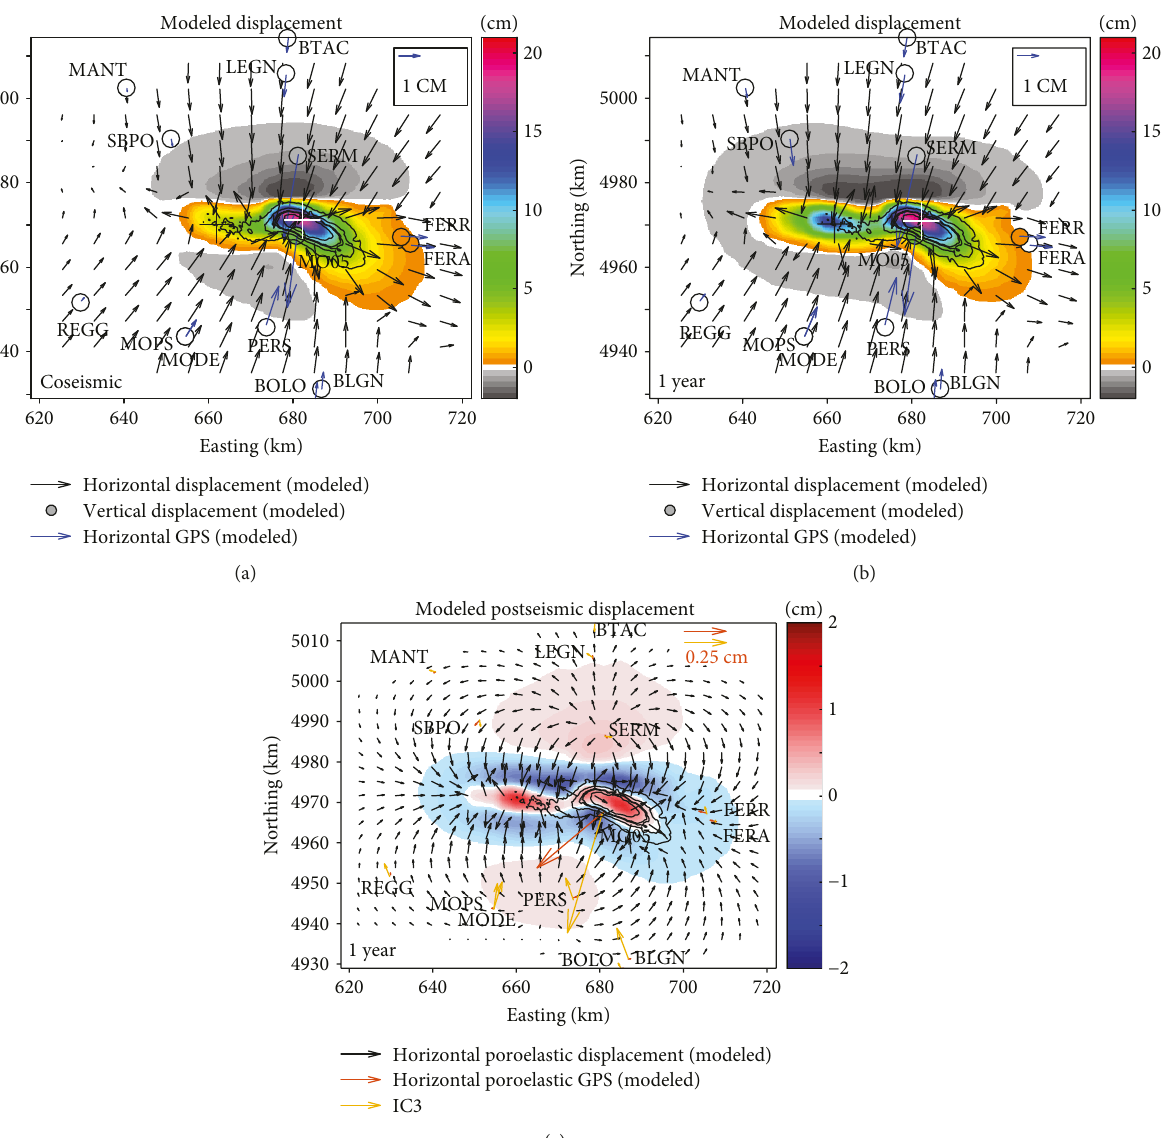
Figure 7: (a) Modeled coseismic vertical displacement and (b) after 1 year (color scale) under scenario S2. Black arrows: modeled horizontal displacement (logarithmic scale). Blue arrows: horizontal displacement modeled in the GPS locations (linear scale). The two white and black crosses are points 1 and 2 in Figure 1. (c) Modeled poroelastic postseismic vertical displacement (color). Yellow arrows: spatial distribution for the IC3 at GPS locations after 1 year (U-ICA3 in Figure 2(e)). Red arrows: modeled horizontal poroelastic postseismic displacement at GPS locations after 1